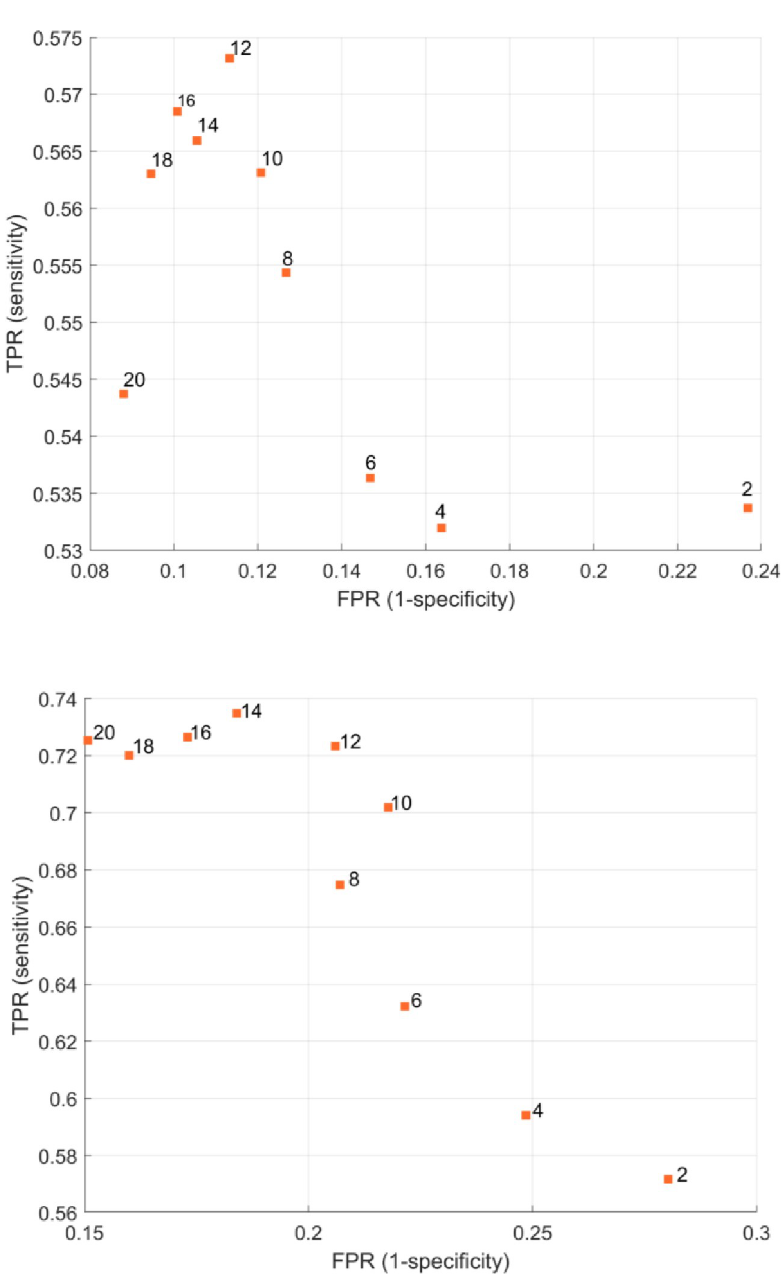
Fig 5. The Receiver Operator Curve (ROC) of the RF using different window size where the top panel is the ROC of the RF using the time domain features and the bottom panel is the ROC of the RF frequency domain